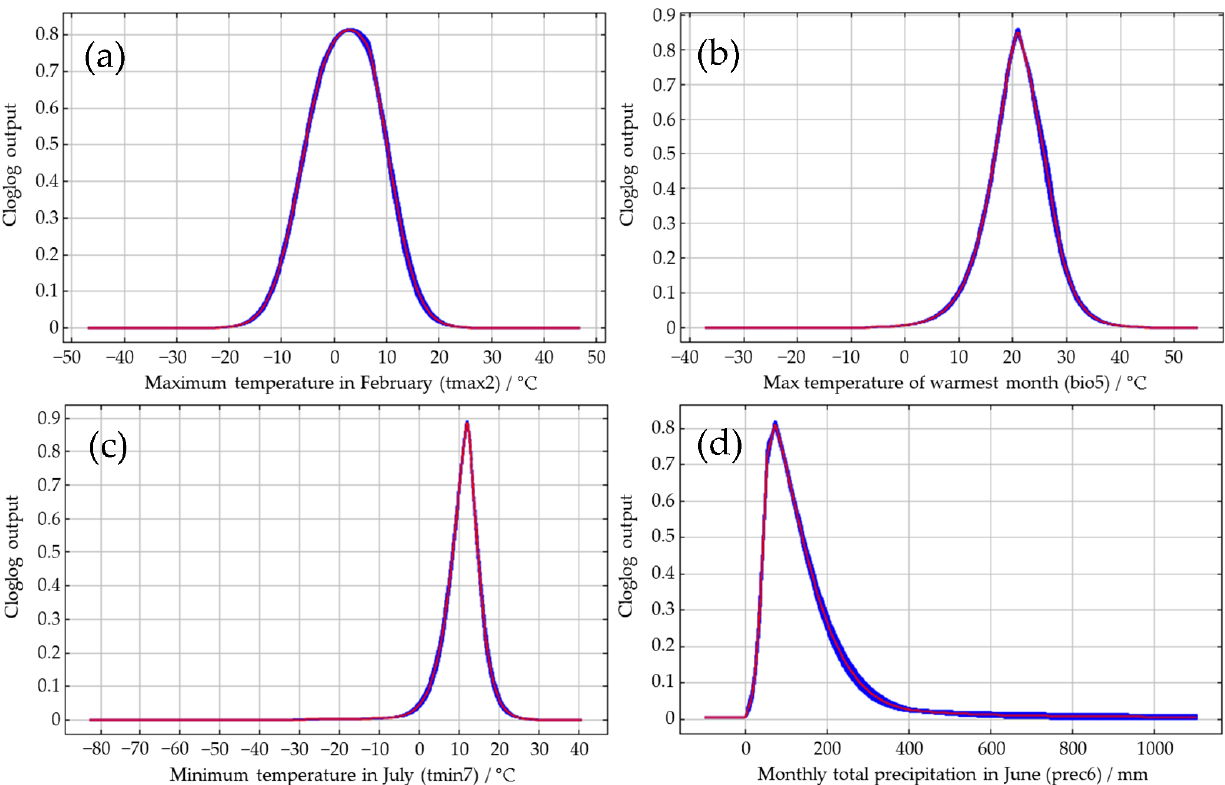
Figure 6. Response curves between the distribution probability of S. juvencus and environmental variables: ( a ) Maximum temperature in February; ( b ) Max temperature of warmest month; ( c ) Minimum temperature in July; ( d ) Monthly total precipitation in June. Values shown are average over 20 replicate runs: blue margins show ± SD calculated over 20 repli- cates.